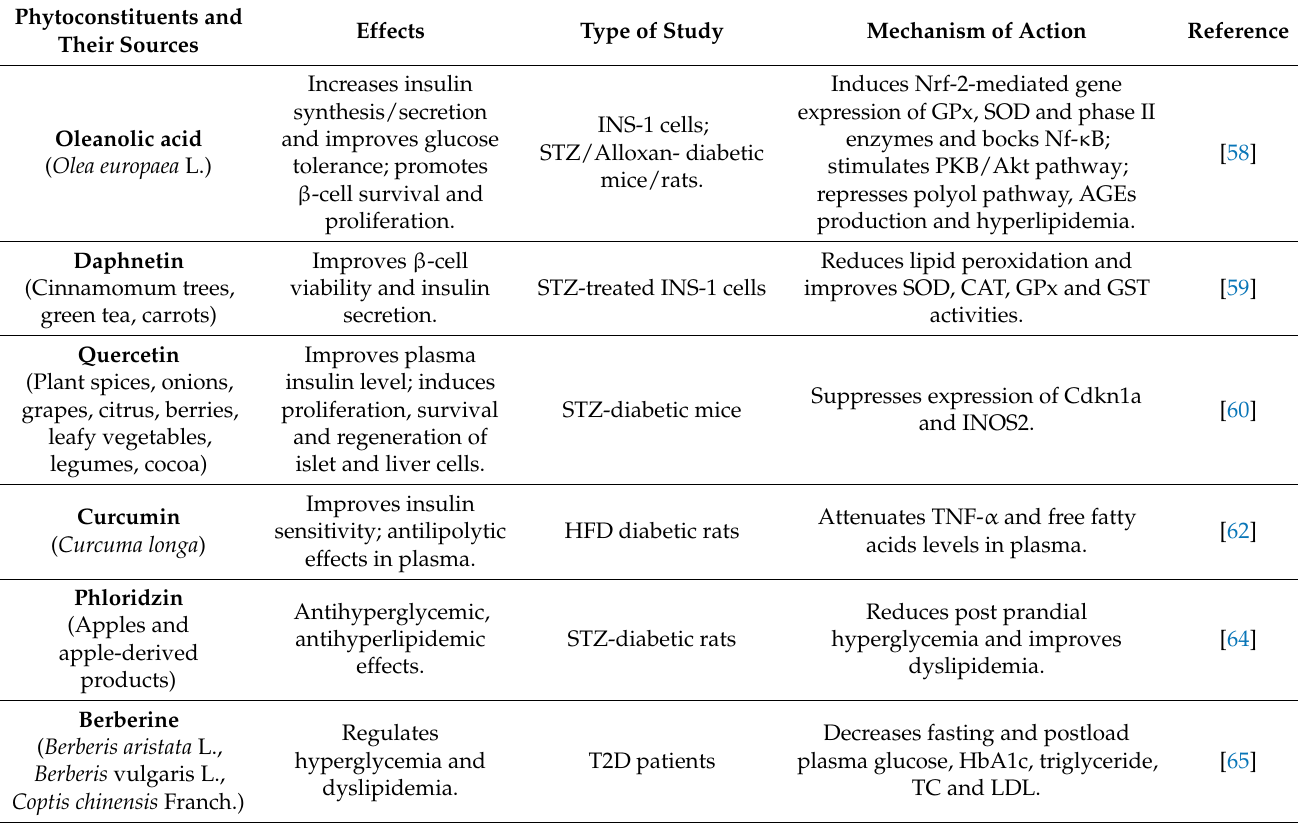
Table 4. Improvement of glucose homeostasis, β -cell viability and function by